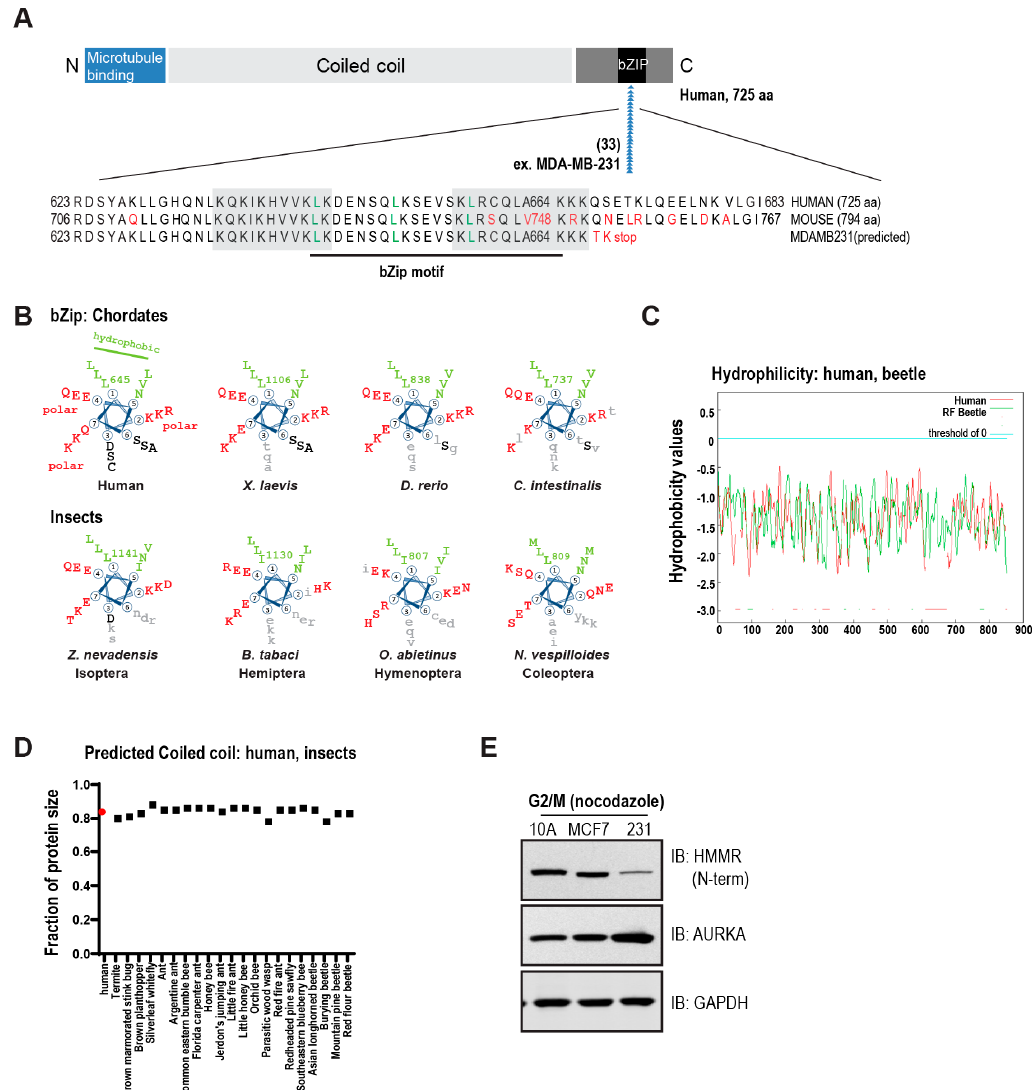
Figure 1. Conserved structural domains in chordate and insect Hyaluronan mediated motility receptor (HMMR). ( A ). The N-terminal microtubule-binding domain (blue) is separated from a C-terminal basic leucine zipper motif (bZIP, black) by a large predicted coiled-coil domain. The C-terminus targets the protein to the centrosome and regulates ubiquitination. Somatic mutations in HMMR occur at a hotspot in the bZIP motif and give rise to frameshift mutations that truncate or alter the C-terminus (ex. MDA-MB-231). The basic motifs in HMMR that interact with hyaluronan (HA) are boxed in grey. Conserved leucines are indicated in green for the bZIP motif, which is underlined in black. ( B ). Conservation of the bZip motif in vertebrate and invertebrate animals. Leucines (position 1) and hydrophobic residues (position 5) that comprise the hydrophobic face (green) are conserved. Polar residues (red) are also conserved while positions 3 and 6 show more variability (grey). ( C ). Hydrophobicity plots (AlignMe) comparing human HMMR (075330) with an Hmmr-like product in Red Flour beetle (D2A2B7, 813 aa). ( D ). Length represented as a fraction of total protein size for the predicted coiled coil length in human HMMR (red) and Hmmr-like gene products identified in insect species. ( E ). MDA-MB-231 cells contain an A 664 frameshift mutation and express reduced levels of HMMR. The reduced expression for HMMR in MDA-MB-231 cells is not due to cell cycle distribution as levels are reduced in lysates from nocodazole-synchronized G2/M cells. Glyceraldehyde 3-phosphate dehydrogenase (GAPDH) serves as a loading control and Aurora kinase A (AURKA) serves as a control for the expression of a cell cycle-regulated gene product in the cell